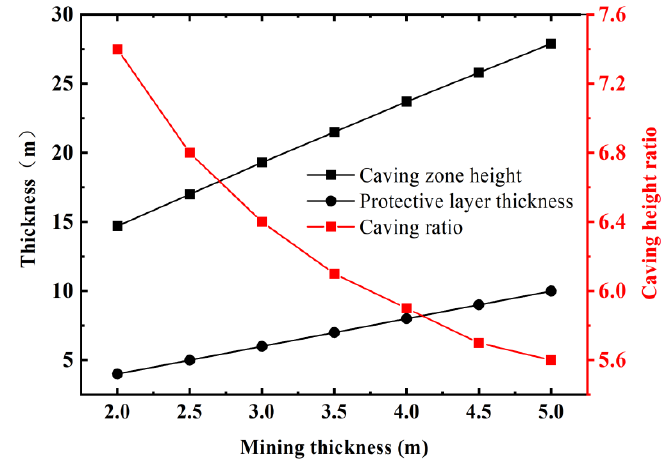
Figure 5. Protective layer thickness, caving zone height, and caving height ratio versus mining thickness.